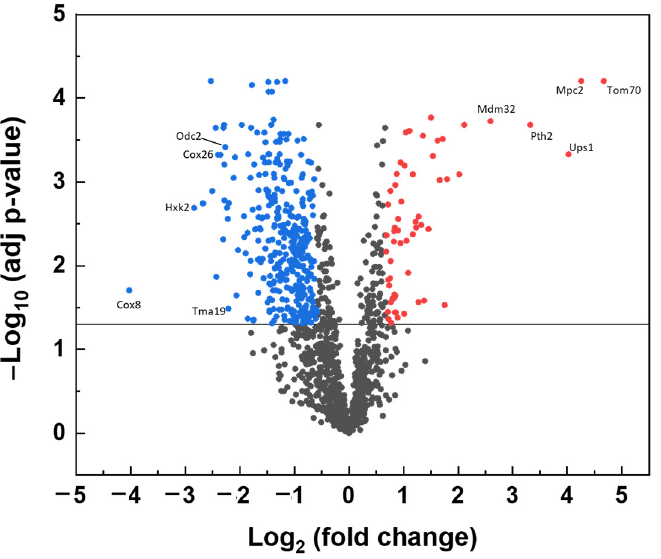
Figure 5. Volcano plot of effect of Δ yme1 on mitochondrial protein abundance compared with the WT mitochondria. The vertical axis corresponds to the significance of individual protein abundance changes, as a –Log 10 (adjusted p -value), with the solid line at a cut off of p = 0.05. The horizontal axis displays the Log 2 (fold change) value. The proteins with increased abundance in the mutant higher than 1.5 (Log 2 = 0.585) and statistical significance (adjusted p < 0.05) are shown in red, and with corresponding decreased abundance in blue. Examples of mitochondrial proteins with more than 4–fold changes are labelled.